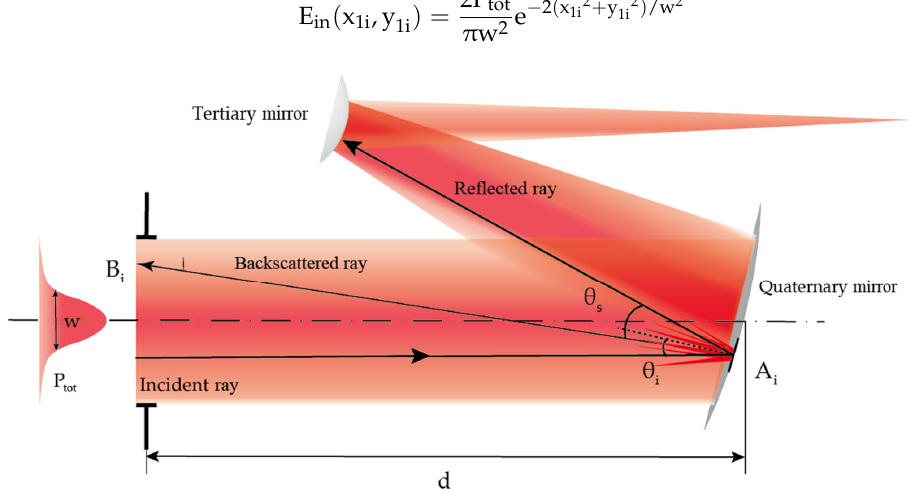
Figure 4. Illustration of a backscattered ray of the quaternary mirror which is recoupled to the in ‐ terferometer.